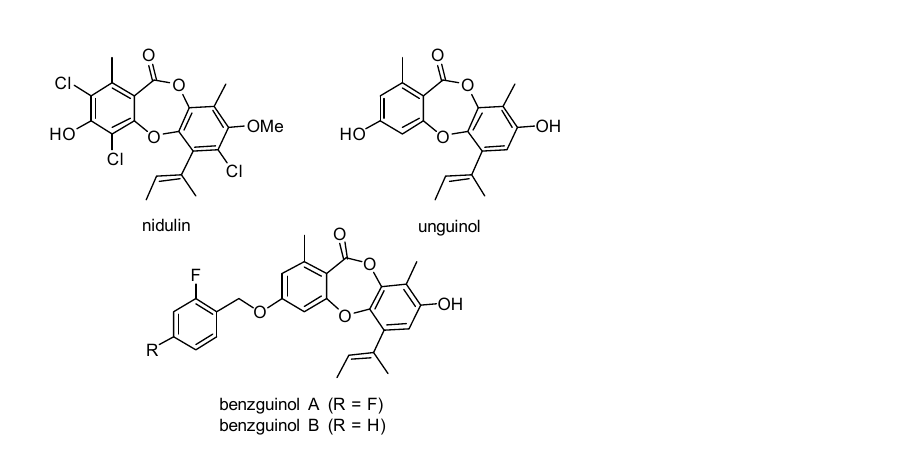
Figure 1. Structures of fungal metabolites nidulin and unguinol and semisynthetic unguinol deriv- atives benzguinol A and benzguinol B.